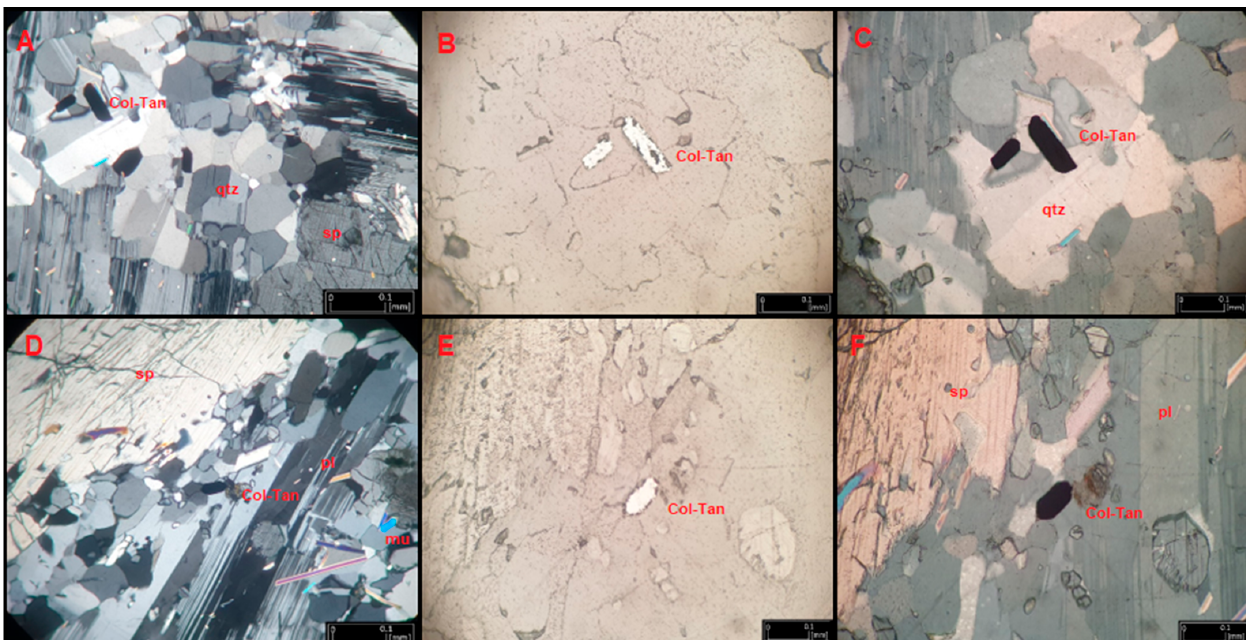
Figure 6. Images of columbite–tantalite (col-tan) in transmitted light ( A , D ) and reflected light ( B , C , E , F ), and under unpolarized light ( B , E ) and polarized light ( A , C , D , F ), showing the optical properties of this sample.